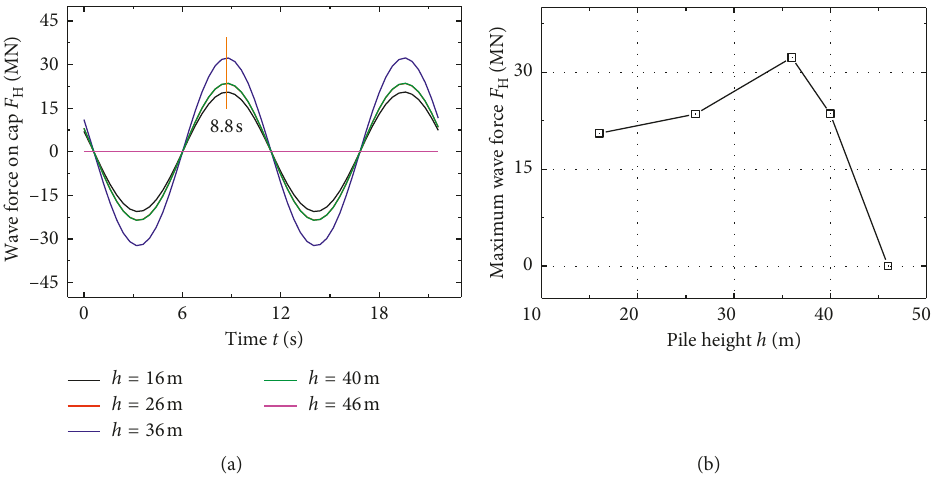
Figure 6: Total wave force on a cap with different pile lengths. (a) Time series. (b) Maximum